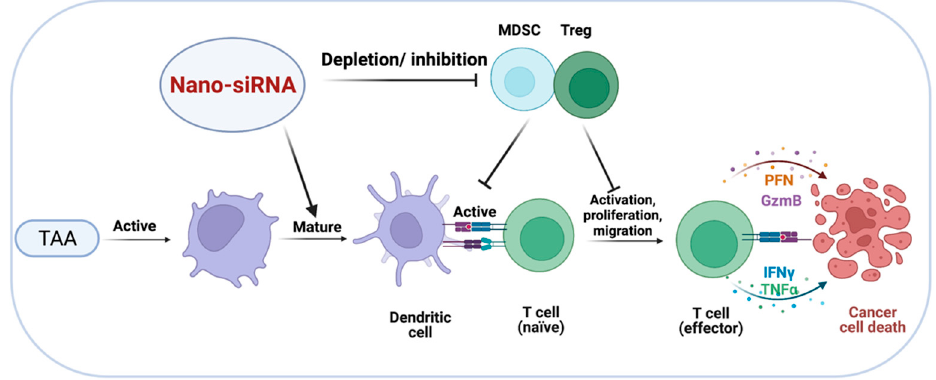
Figure 4. Targeted delivery of siRNA to MDSCs and Tregs. Depletion of Tregs and MDSCs or suppression of their immunosuppressive effects may restore the antitumor activity of effector T cells, resulting in cancer cells’ death.